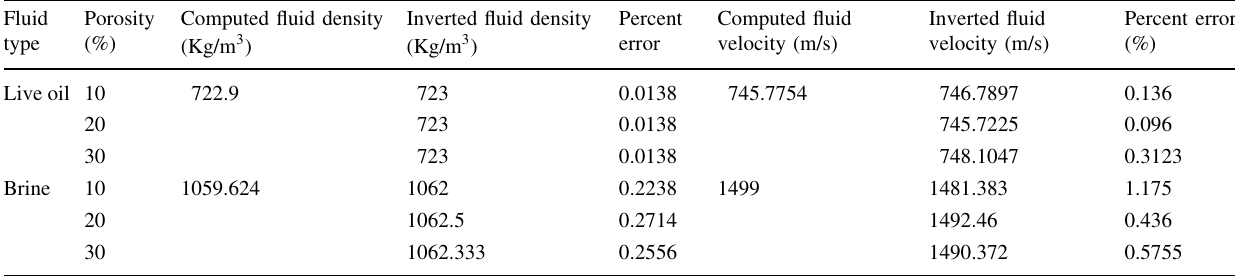
Table 10 Percent error analysis in the Arab formation Fluid Porosity type